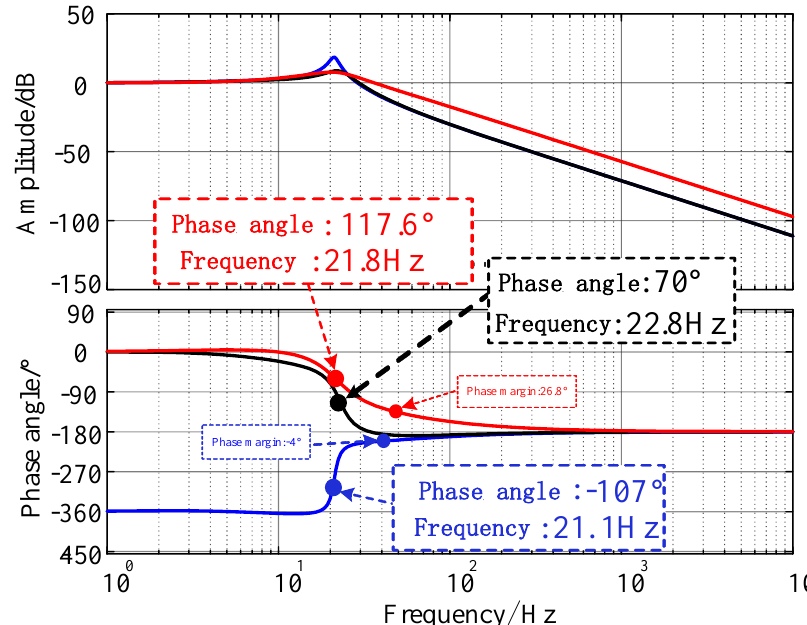
Figure 10. Bode plot. Blue, red and black curves represent H cmax = 0.4, H cmax = 0.6 and H cmax = 0.9